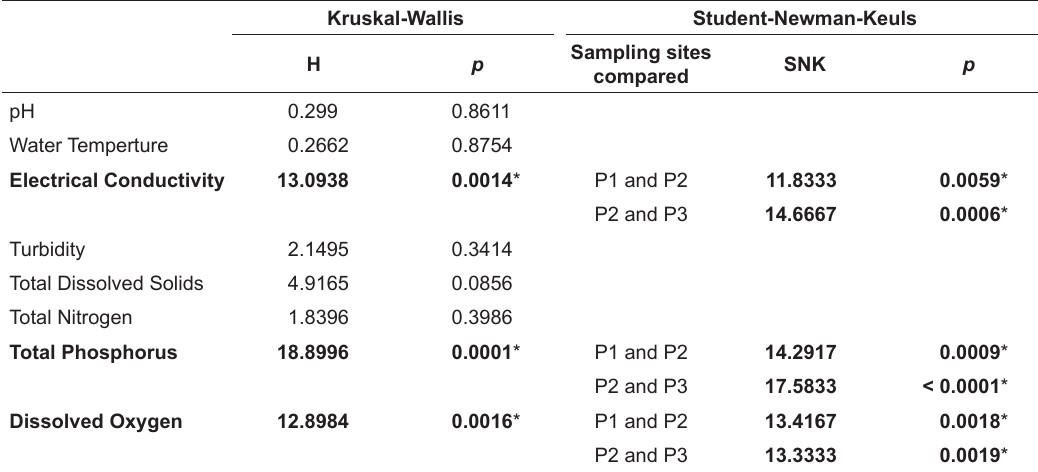
Figure 3. Principal component analysis (PCA) to verify the ordering of the sampling sites in relation to the intensity of the association among the abiotic variables. The numbers represent the collections (samples): C1 (17.04.12), C2 (22.05.12), C3 (26.06.12), C4 (26.06.12), C5 (13.09.12), C6 (24.09.12), C7 (06.11.12), C8 (04.12.12), C9 (18.12.12), C10 (17.01.13), C11 (05.03.13) and C12 (26.03.13). The lines (convex hull) indicate the cloud (data points) represented by the measurements at each site: P1 - Taquacetuba (blue), P2 - Alvarenga (red) and P3 - Biguás Island (green) at Billings Reservoir (Brazil, Sao Paulo State). The vectors (dark green) show the contributions of the variables pH, temperature (Temp), electrical conductivity (Cond), turbidity (Turb), total dissolved solids (TDS), total nitrogen (N), total phosphorus (P) and dissolved oxygen (DO) in the formation of the first two components of the Table 1. Results of Kruskal-Wallis test (H) and subsequent Student-Newman-Keuls (SNK) test for abiotic variables among the sampling sites.